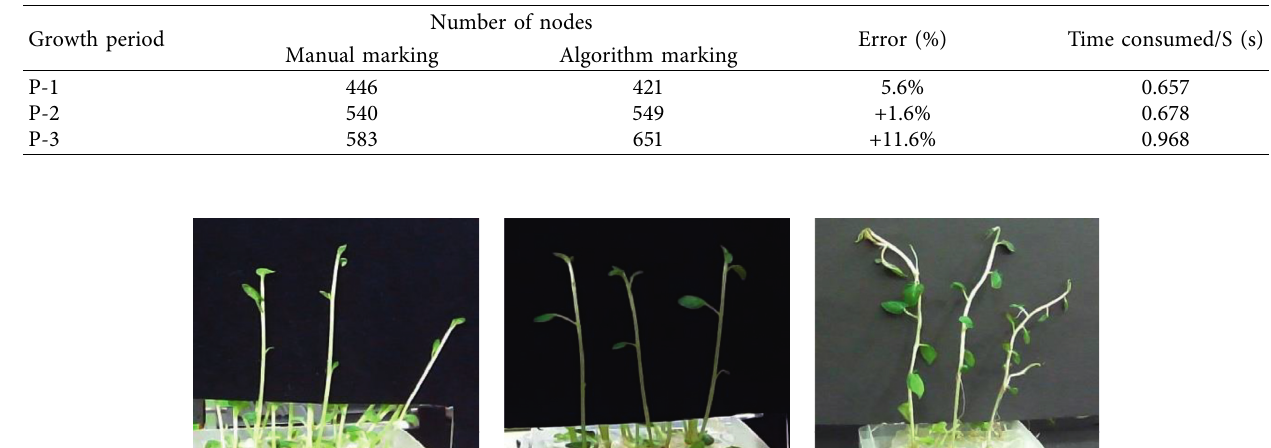
Table 3: The performance of the node detection algorithm in this paper.